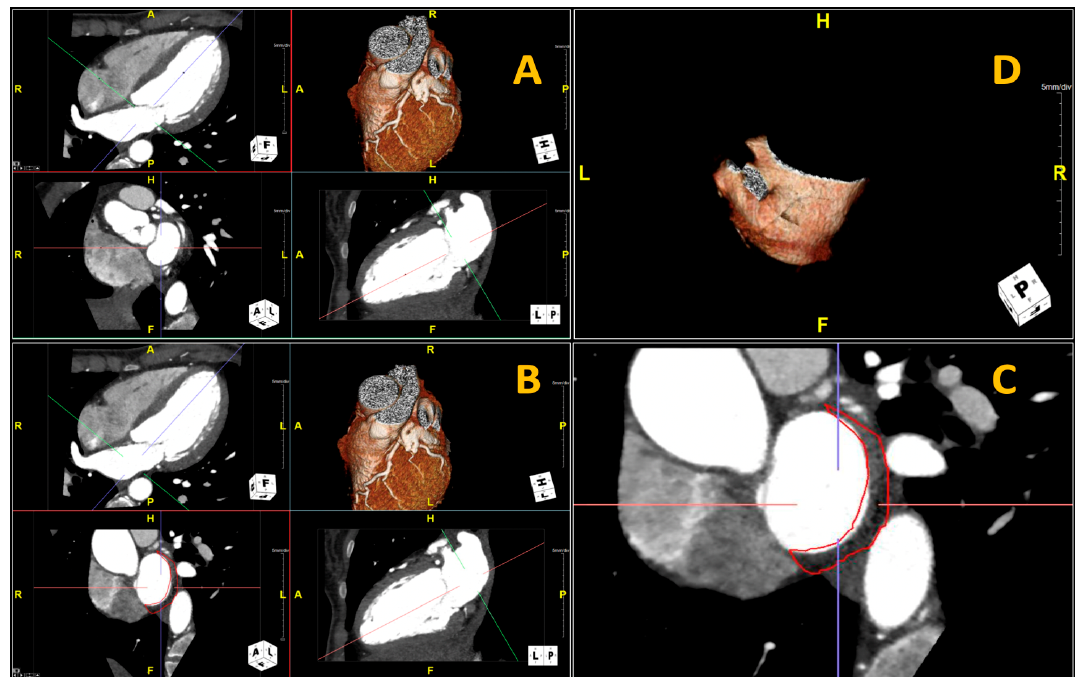
Figure 1. Reconstruction of the cross-sectional view of the left atrium, to measure the adipose tissue located posterior to the left atrium volume and attenuation on the cardiac computed tomography angiogram. ( A ) represents the first slice selected at the coronary sinus position and in ( B ) one slice in the mid-atrial position. ( C ) shows the manually traced region of interest (ROI) of a specific slice. ( D ) shows the reconstruction of three-dimensional ROI.